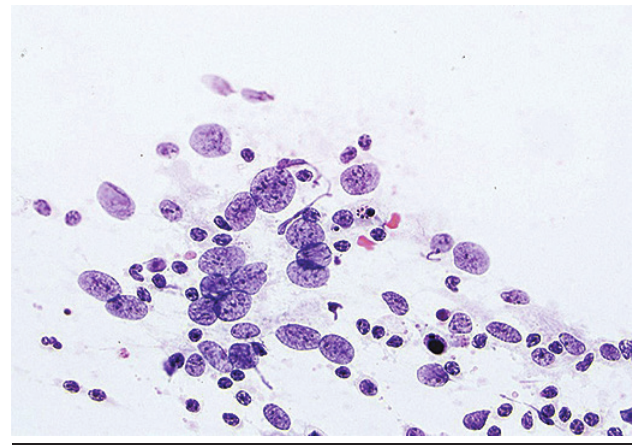
figurE 1 − Blue stain method, 200× LSIL: low-grade squamous intraepithelial lesion.